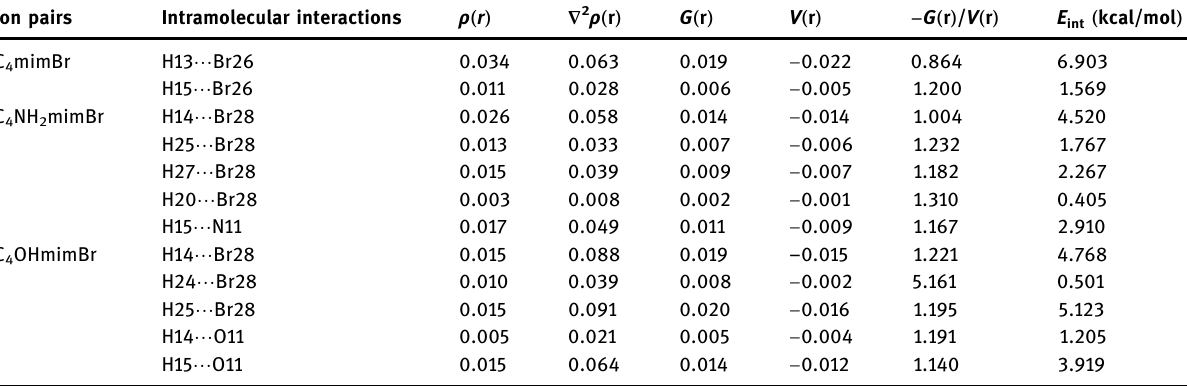
Table 2: Topological parameters of the QTAIM in C 4 mimBr, C 4 NH 2 mimBr, and C 4 OHmimBr Ion pairs Intramolecular interactions